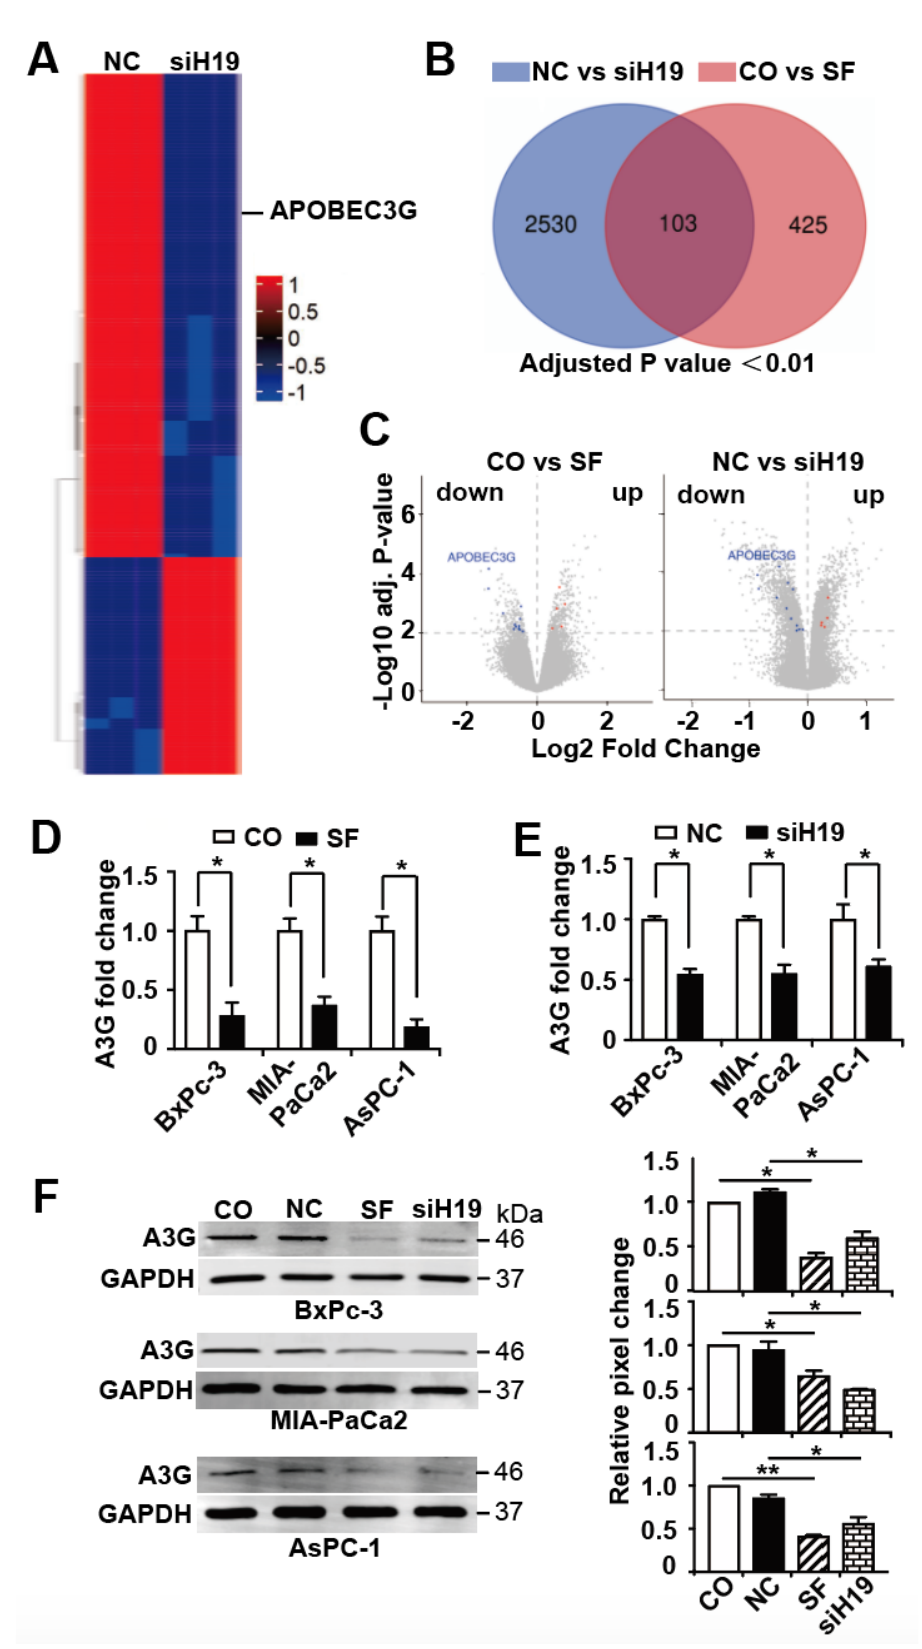
Figure 3. APOBEC3G is targeted by H19 and inhibited by sulforaphane or H19 knockdown. ( A ) MIA-PaCa2 cells were lipo-transfected with nonsense siRNA control (NC) or H19 siRNA (siH19), 20 µ g each, and the total RNA was harvested 24 h later, followed by hybridization with a GeneChip™ miRNA 4.0 Array in triplicate and bioinformatic evaluation. The resulting heat map presents the top 200 most significantly up- or downregulated genes (red: high expression; blue: